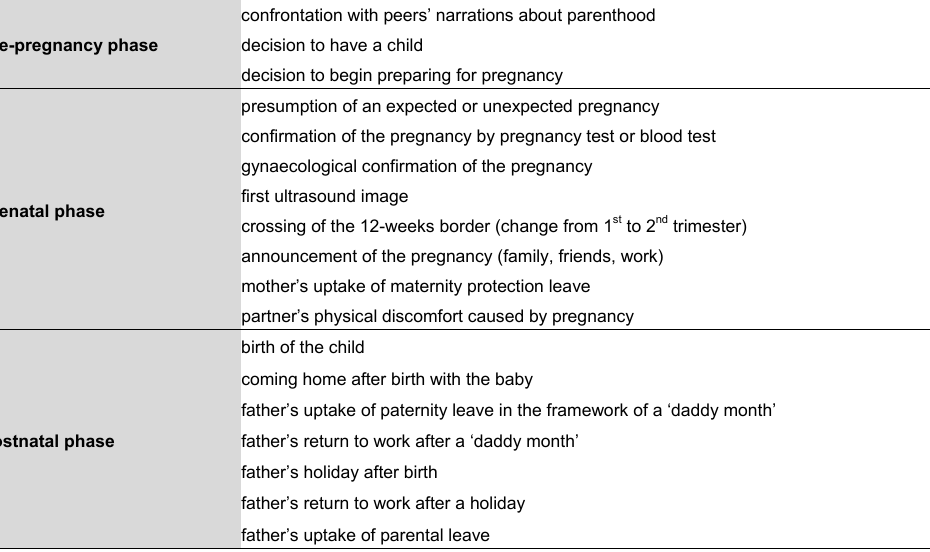
Table 2: Turning points in the transition to parenthood confrontation with peers’ narrations about parenthood Pre-pregnancy phase decision to have a child decision to begin preparing for pregnancy presumption of an expected or unexpected